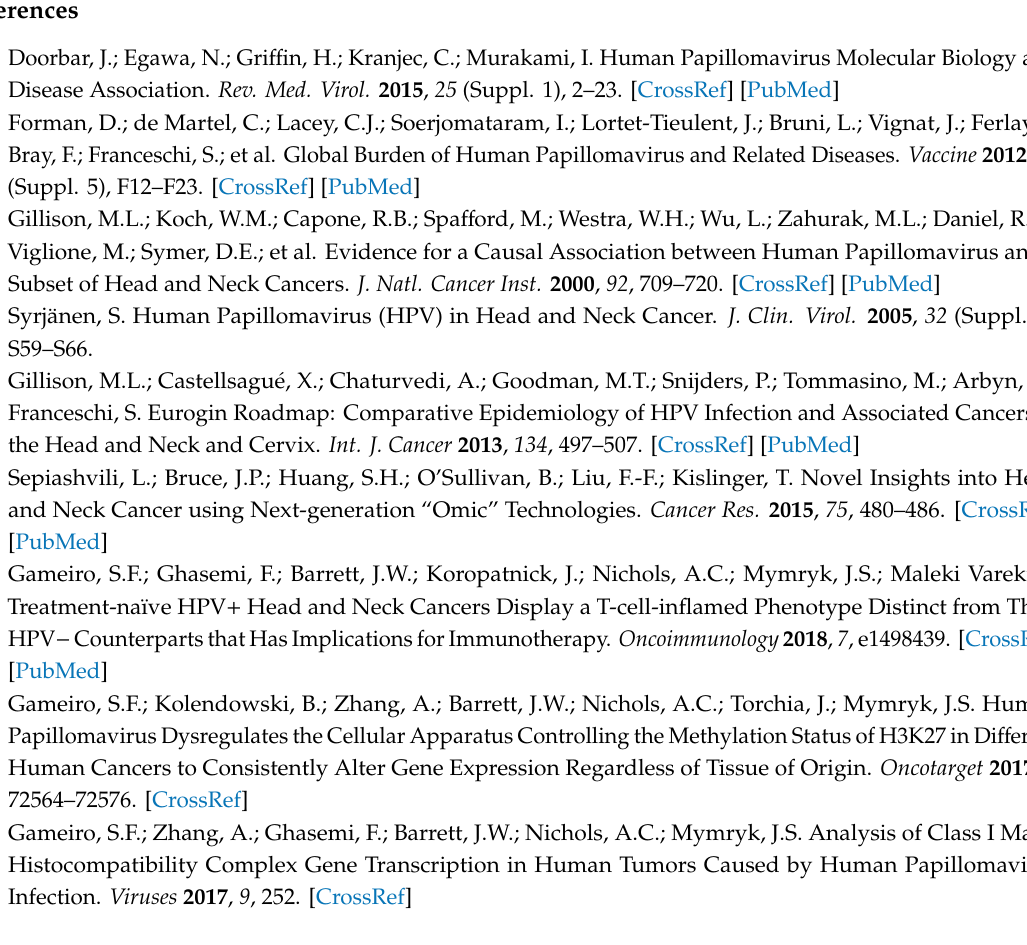
Figure S1: Gene expression reanalysis in the oropharynx. Figure S2: Gene expression comparisons of (A) APC and (B) Epithelia markers. Table S1: MHC-II genes pairwise correlation, Spearman coe ffi cients, and